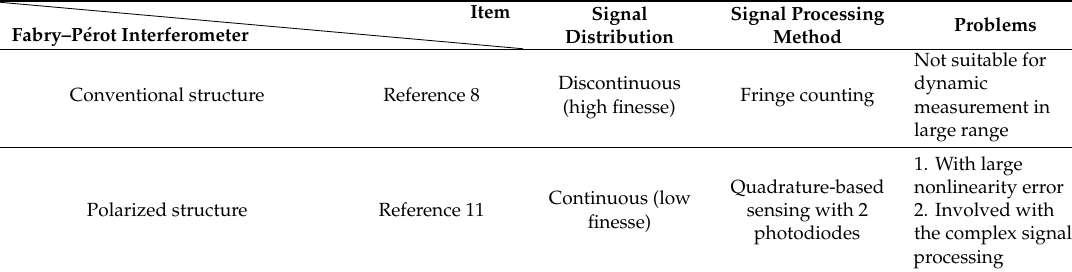
Table 1. Comparison between the previous Fabry–P é rot